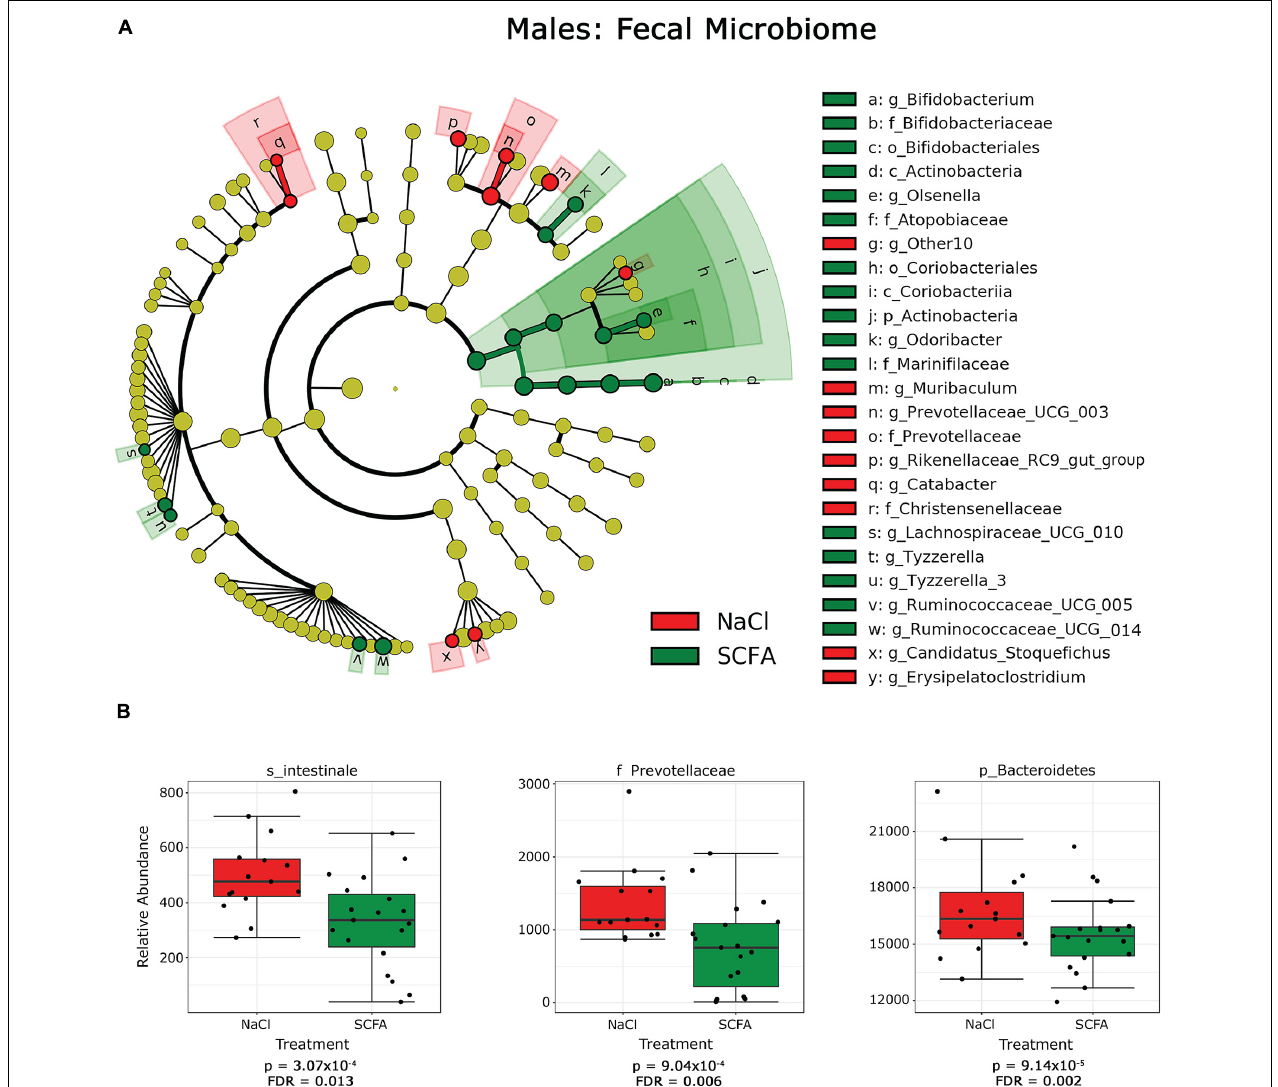
FIGURE 3 | Cladograms and box plots of individual taxa reveal microbial phylogenetic branches associated with short chain fatty acid (SCFA) supplementation in male mice. (A) Taxa are represented as nodes that are connected by lines based on the phylogenetic relatedness of all taxa present in each experimental cohort. For example, the end node, a, represents the genus Bifodobacterium which is connected to other nodes representing higher level taxa related to Bifodobacterium including b the family Bifidobacteriaceae, c the order Bifidobacteriales, and d the class Actinobacteria. Many taxa are associated with SCFA vs saline treatment, with node colors indicating treatment with highest levels of each taxa. Statistical significance reflects both p < 0.05 for Kruskal-Wallis tests and a logarithmic LDA score > 2.0. (B) Box plots present the relative abundance of individual taxa that are significantly associated with SCFA supplementation by classical univariate analysis. A full list of taxa with nominal p -values and FDR corrected p -values is provided in Supplementary Material 1.1–1.6